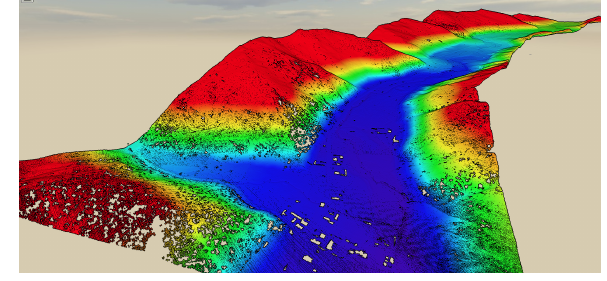
Figure 17 . Ground class used to extract DTM